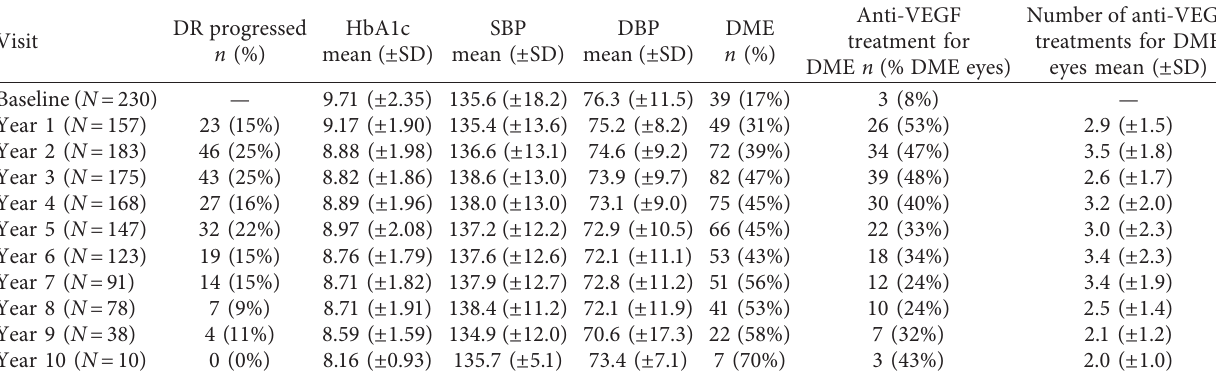
Table 4: Summary statistics for variables collected during the follow-up period by year.